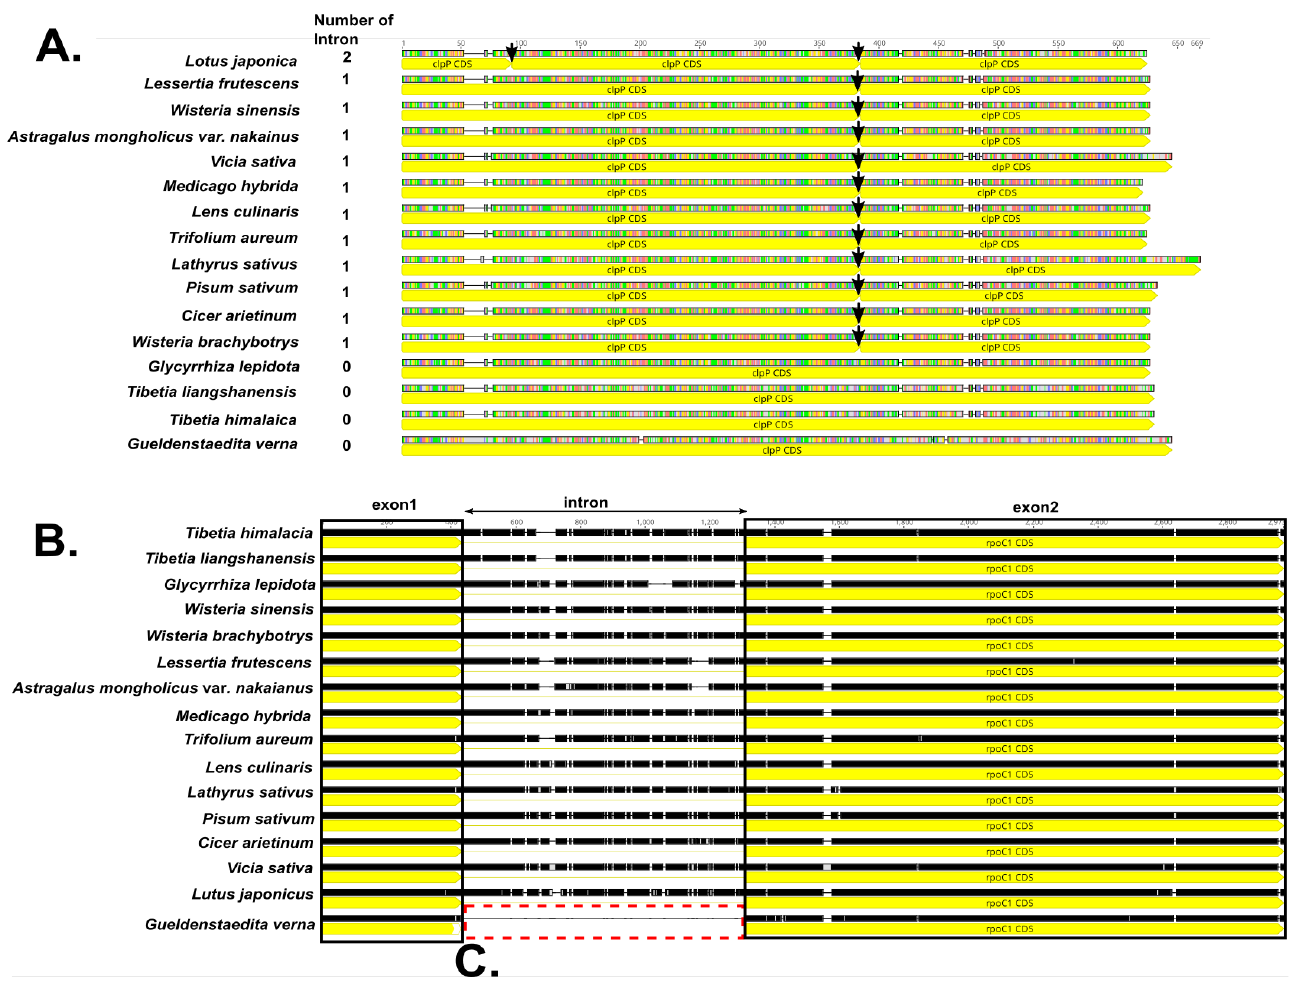
Figure 2. Introns of clpP and rpoC1 in 19 inverted repeat-lacking clade (IRLC) species. ( A ) Introns of clpP in IRLC species. Arrows indicate intron locations. ( B ) Introns of rpoC1 in IRLC species. ( C ) Loss of rpoC1 intron in G. verna .